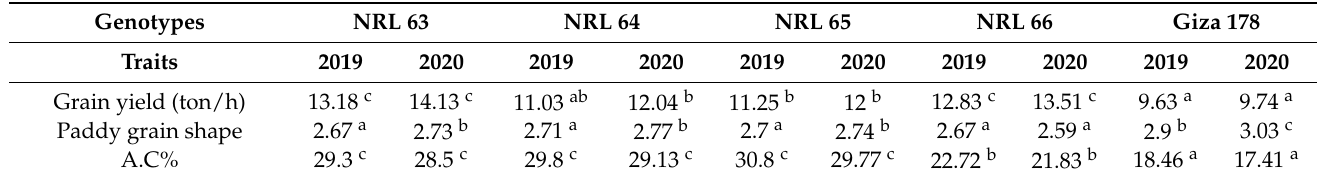
Table 2. Mean performances for rice grain yield, grain shape (L/B ratio), and amylose content percentage traits of the studied genotypes during the 2019 and 2020 growing seasons.